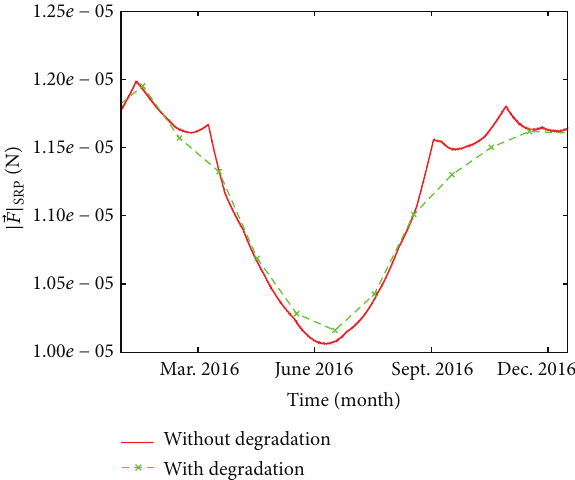
⃗𝐹| Figure 15: Comparison: | SRP for the FE model with and without degradation for the MICROSCOPE